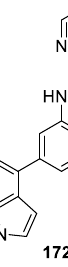
. Figure 56. Chemical structure of 1 H -indazole derivative 175 as LRRK2 inhibitor. Tzvetkov et al. [105] reported the synthesis of a class of N -alkyl-substituted indazole-5- carboxamide derivatives and optimized their Monoamine oxidases inhibitory activities to develop potential drug and radioligand candidates for the treatment of Parkinson's disease (PD) and other neurological disorders. Some analogues showed promising inhibitory activities with nanomolar potency towards MAO-B and were moderately active against the MAO-A enzyme, respectively. The most promising derivatives among the tested compounds were 176 (IC 50 hMAO-B 0.662 nM) and 177 (IC 50 hMAO-B 8.08 nM, IC 50 hMAO- A 0.56 μM) (Figure 57). The following studies confirmed that compounds 176 and 177 established binding interactions with hMAO-B via the carbonyl group of the carboxamide linkage and the N1 or N2 nitrogen of the indazole moiety. Figure 57. Chemical structures of N-alkylated indazole-5-carboxamide derivatives 176 and 177. 3.6. Treatment of Anemia of Chronic disease Fukuda et al. [106] reported a novel series of indazole derivatives as lead structures for potent hepcidin production inhibitors for treatment of anemia of chronic disease (ACD). The authors